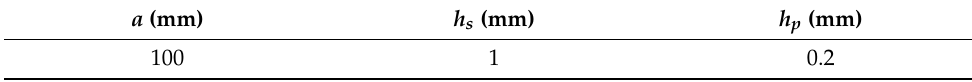
Table 1. Geometrical parameters of the unit cell.